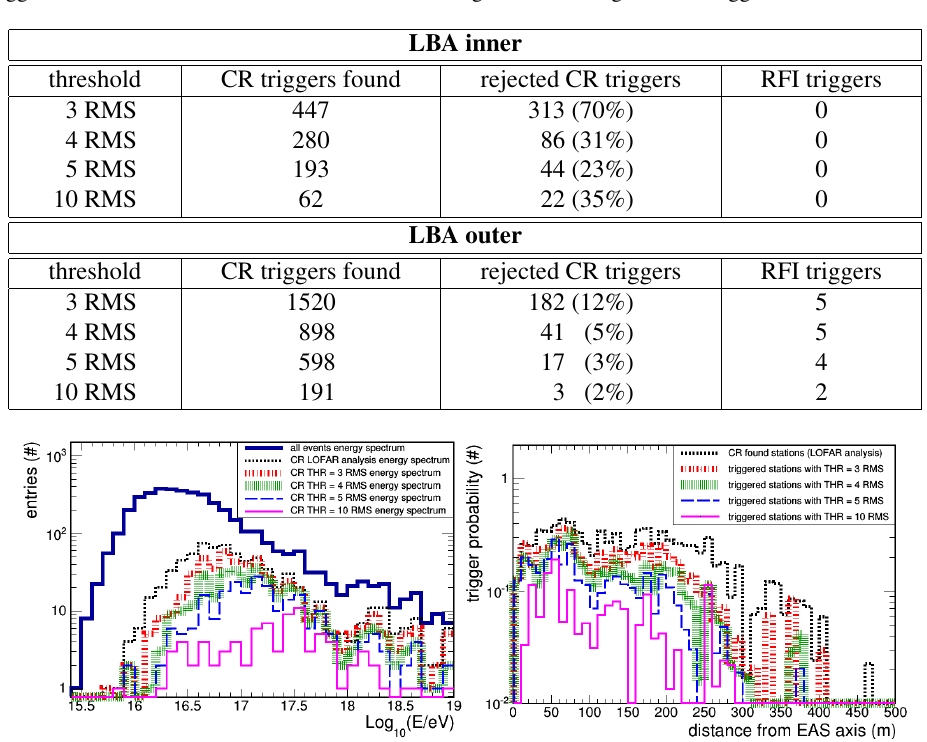
Table 1. Results of the new radio self-trigger algorithm applied on the LORA triggered dataset. Note: since the trigger is evaluated for each individual station, one single shower can generate a trigger on several stations.